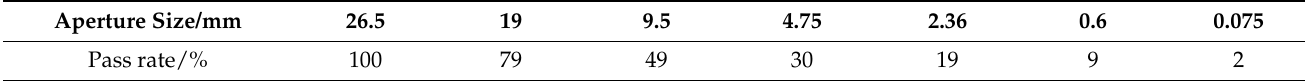
Table 2. Grading result of macadam.